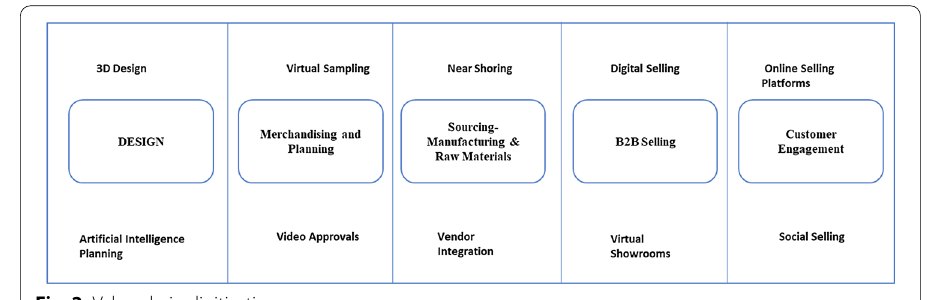
Fig. 2 Value chain